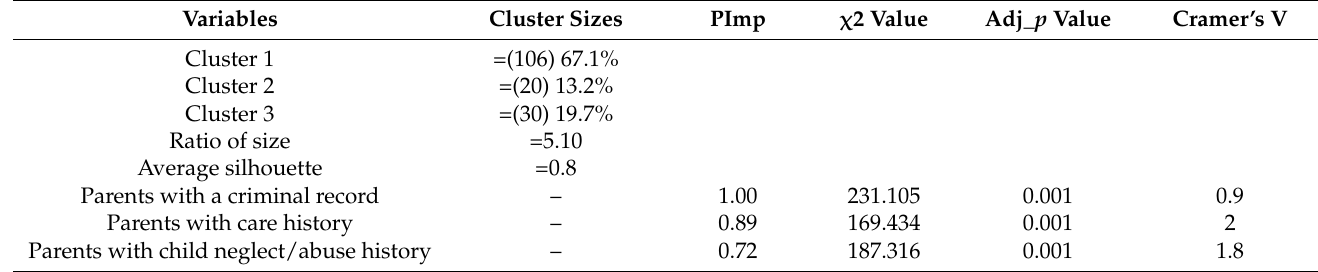
Table 3. The two-step cluster model that classifies the social indicators of the parents of homeless people according to the ratio of size, the average silhouette of the model, PImp values, χ 2 values, and variable-specific Cramer’s V values. Variables Cluster Sizes PImp χ 2 Value Adj_ p